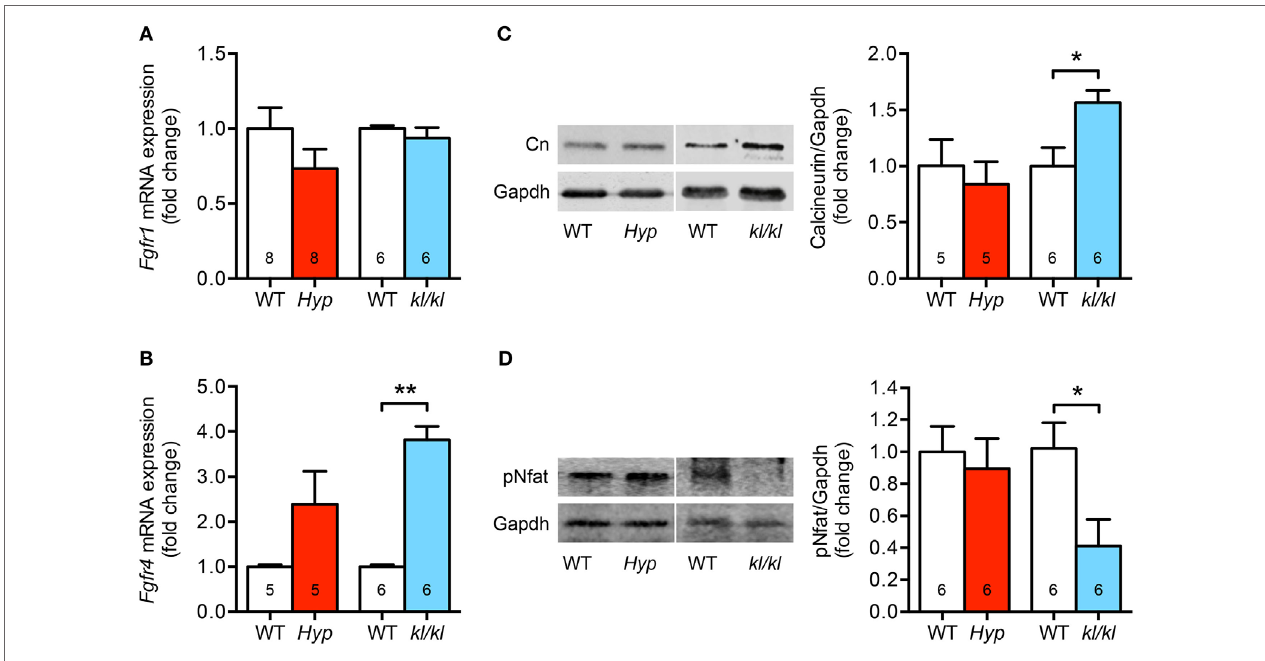
FigUre 3 | The cardiac Fgfr4/calcineurin/nuclear factor of activated T cell signaling is activated in kl/kl mice. (a) Quantitative real-time PCR analysis reveals no significant differences in Fgfr1 mRNA expression in cardiac tissue from both mouse lines compared to their respective wild-type controls. (b) Fgfr4 mRNA expression is elevated in hearts from kl/kl mice as well as Hyp mice; however, the differences are statistically significant only for the kl/kl animals. (c) Representative immunoblot and quantification indicate an upregulation of cardiac calcineurin protein expression only for kl/kl mice (Gapdh served as loading control). (D) Representative immunoblot and quantification of Nfat activation show reduced Nfat phosphorylation in cardiac tissue from kl/kl mice. Values are presented as mean ± SEM; numbers in each bar graph represent the n- values used for the respective measurement; * P < 0.05, ** P <